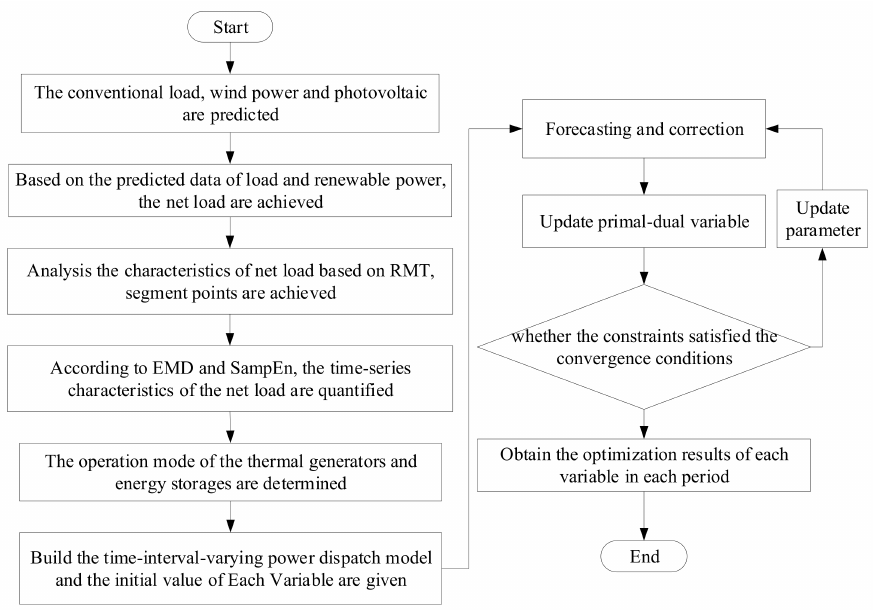
Figure 7. Algorithm and flow chart for solving the time-interval-varying power dispatch model.